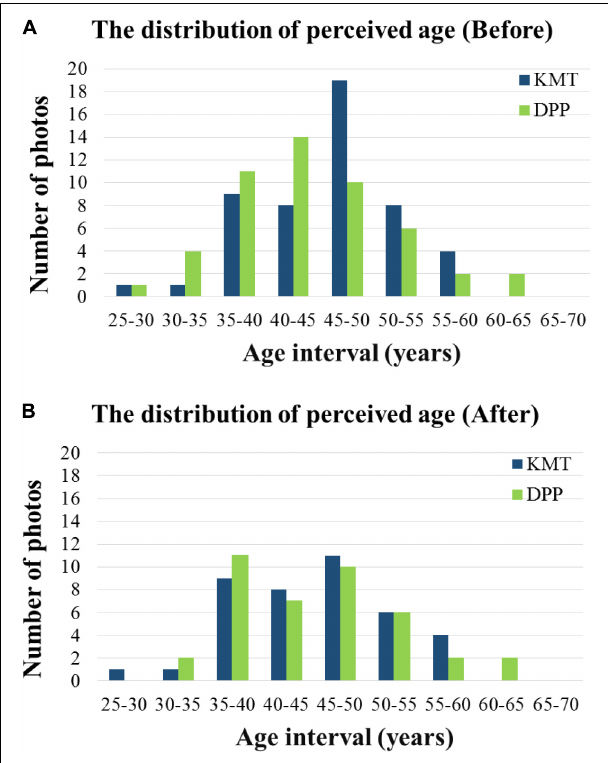
FIGURE 1 | The distribution of KMT and DPP candidates’ photos in the pilot study before (A) and after (B) the adjustment. The abscissa denotes the perceived age interval (in 5 years increment), and the ordinate represents the numbers of photos. The blue bars represent KMT candidates, and the green bars represent DPP